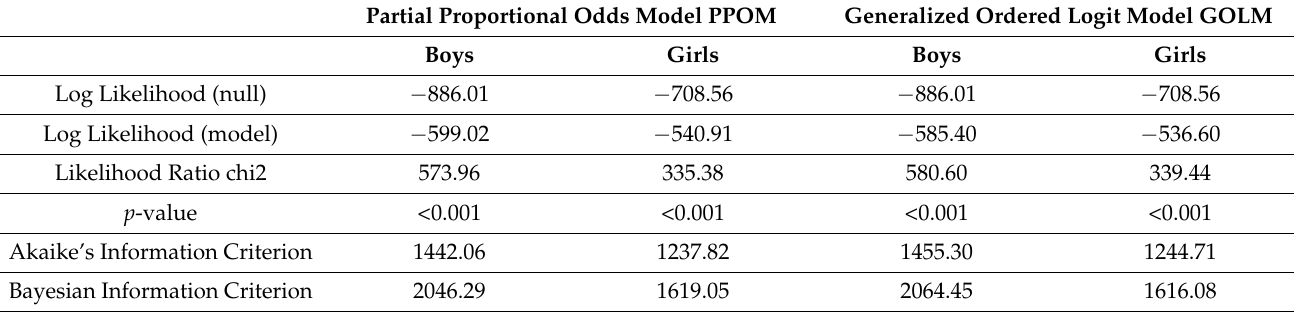
Table A5. Log–likelihood and likelihood ratio estimates.